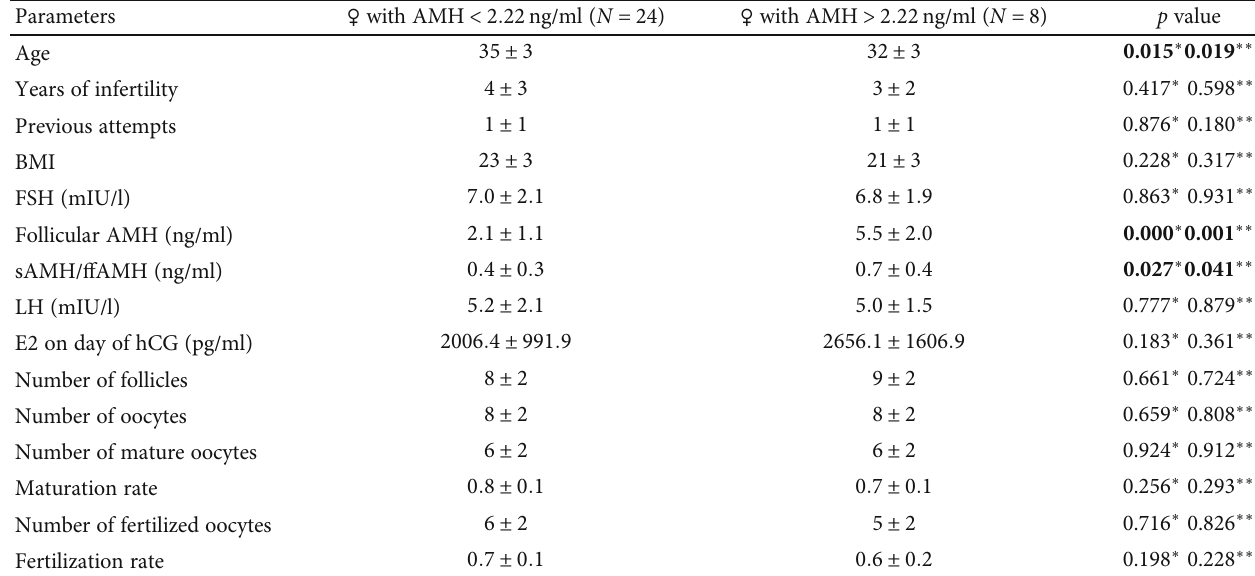
Table 3: Clinical and biochemical pro fi les of women with AMHvalues < 2 : 22 ng/ml (poor responders) and women with AMH values > 2 : 22ng/ml that underwent IVF. ∗ t -test, ∗∗ Mann-Whitney U .